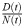
Balanced growth of L1210 cells in the mother machine microfluidic device.(A and B) Schematic representation of the device. (A) The top view of the device. The culture medium flows through the trench (white arrows). Cells trapped in the growth channels are observed simultaneously by time-lapse imaging. (B) A cross-section of the device at the plane corresponding to the broken line indicated by the black arrows in (A). The height and the width of a growth channel are both 20 μm, which corresponds to the size of L1210 cells. (C) A micrograph of L1210 cells in the device. (D) Tracing individual L1210 cell lineages. Twenty representative single-cell lineages of L1210 cells cultured in a constant environment are shown. Each horizontal line represents a single-cell lineage, and the points represent the time points at which cell division occurred. The blue cell lineages are fast-cycling cell lineages, which divided 12 times or more during the seven-day culture; the red cell lineages are slow-cycling cell lineages, which divided 11 times or less during the same period. Co-existence of the heterogeneous growth phenotype is further discussed in the main text. (E) Constant division rate. At each time point t, we estimated an instantaneous cell division probability as D(t)N(t), where N(t) is the number of surviving cells, and D(t) is the number of cells that underwent cell division within the time-lapse interval (t, t + Δt]. Δt is 10 min throughout this study. The vertical axis is the cumulative sum of instantaneous division probability, i.e., ∑t′=0tD(t′)N(t′). Blue points represent the experimental data. The black broken-line is the line of linear fit; the slope is (9.033±0.003) × 10−2 h−1. The cumulative sum of division probability increases linearly with t, which indicates that the division rate was constant throughout the observation period. (F) Constant death rate. The fraction of surviving cell lineages was plotted over time with the vertical axis on the log scale. Blue points are the experimental data. Black broken-line is the line of linear fit; the slope is −(2.239±0.009) × 10−3 h−1. The surviving fraction decreased in an exponential manner, which indicated a constant death rate throughout the observation period.